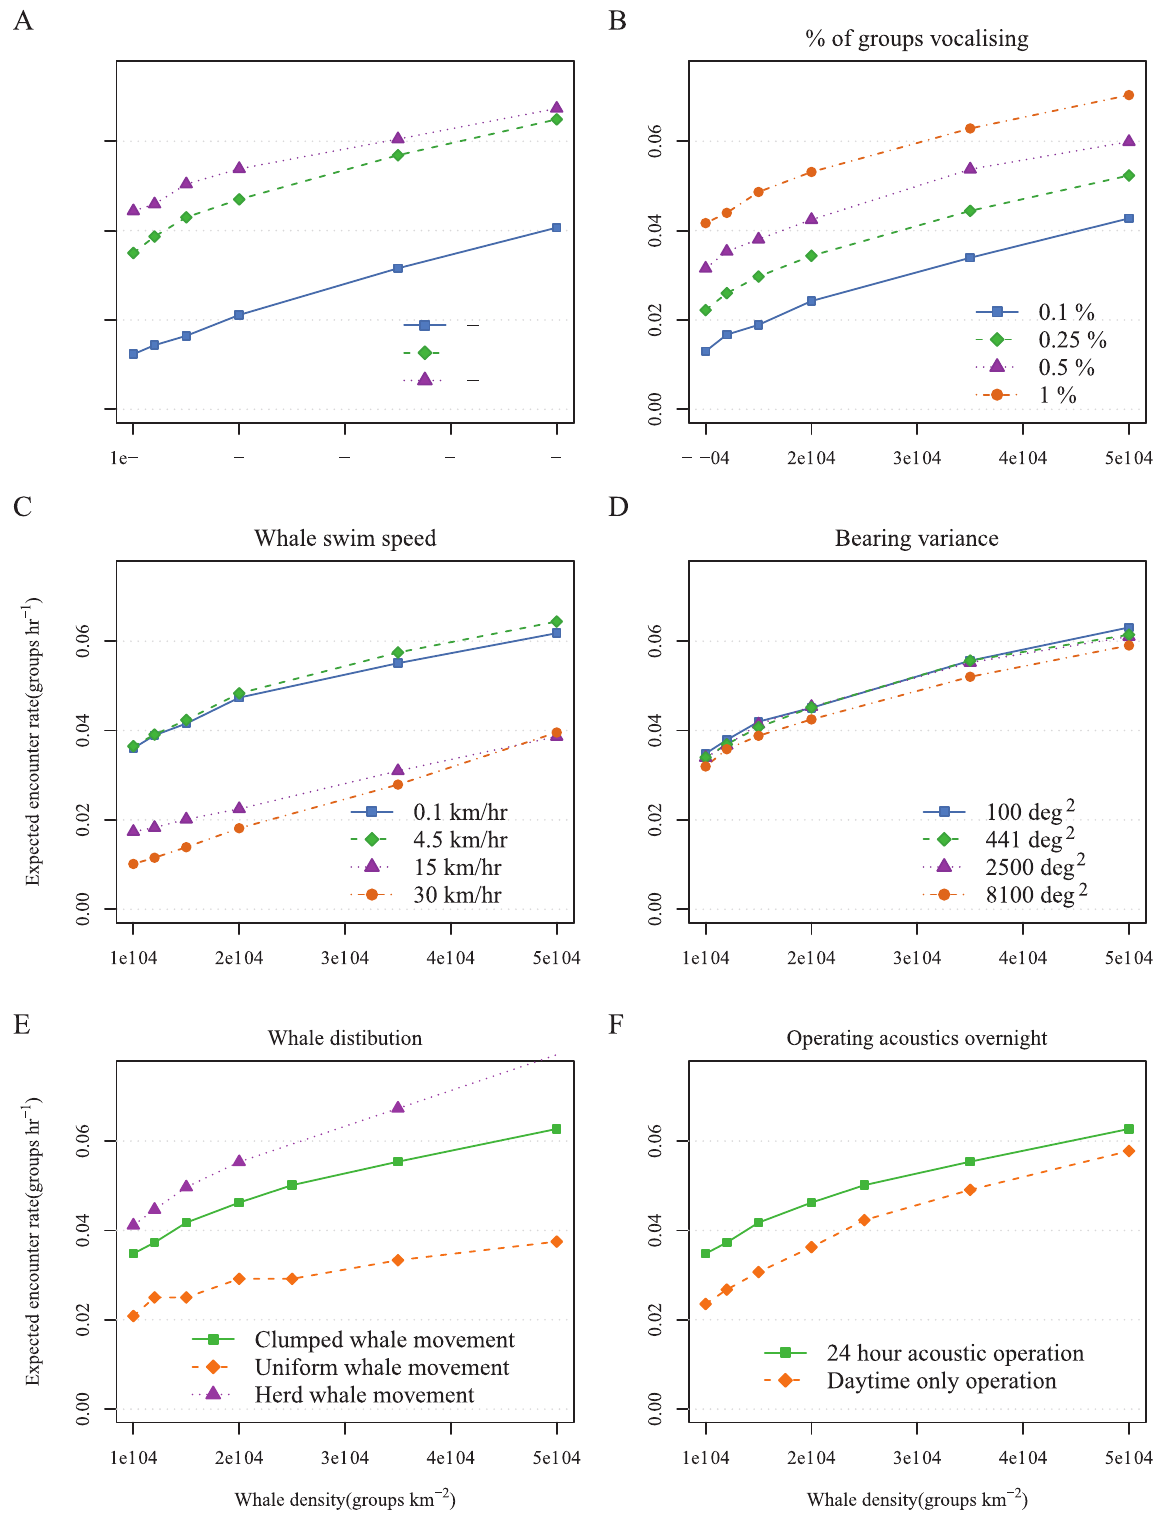
Figure 6. Results from the sensitivity study. Sensitivity study of mean encounter rate to (A) acoustic detection range, (B) percentage of whale groups vocalizing, (C) whale swim speed, (D) sonobuoy VHF range, (E) comparison of acoustically-assisted encounter rate from operating acoustics 24 hours a day versus daylight hours (6 am–6 pm) and (F) the effect of clumped distribution/movement versus uniform distribution of groups.